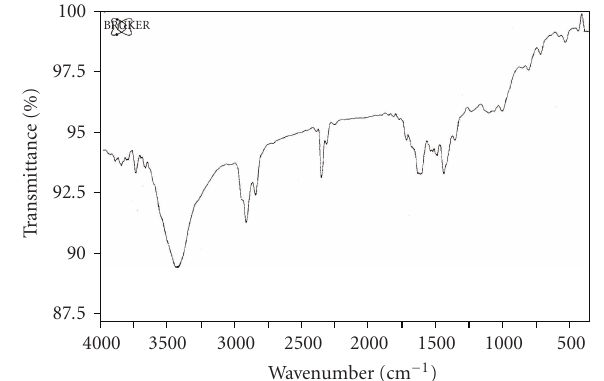
Figure 4: IR spectrum of natural rubber.